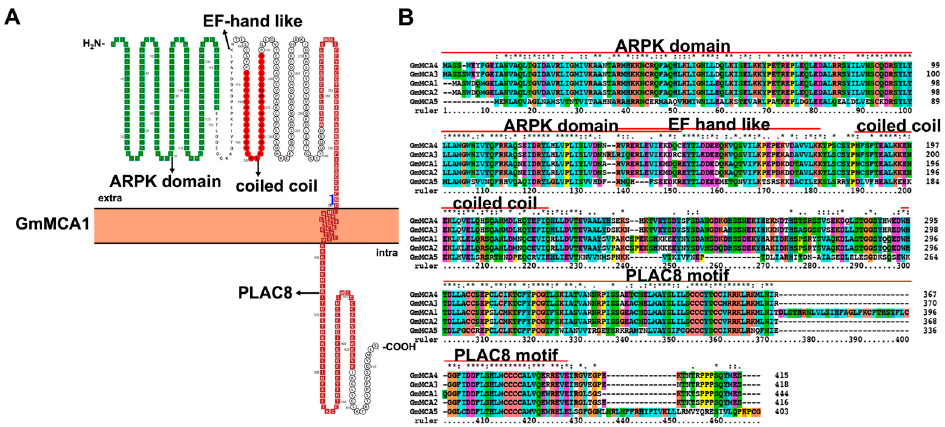
Figure 8. Topology model ( A ) and homology analysis ( B ) of soybean mid1-complementing activity (MCA). The protein topology figure was constructed by using Protter [25]. The protein sequences were aligned by using ClustalX1.83 (http://www.clustal.org/download/, accessed on 17 October 2022).